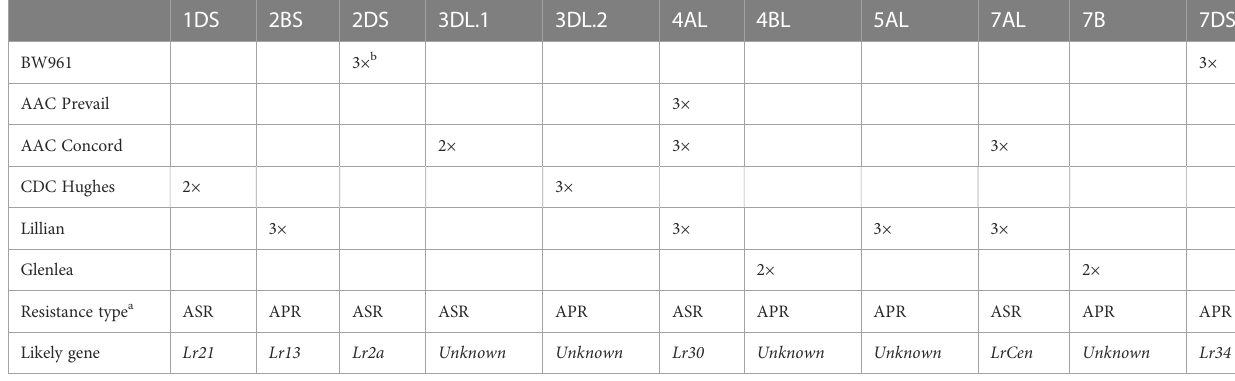
TABLE 4 Summary of QTL that were identi fi ed in the AAC Prevail/BW961, CDC Hughes/AAC Concord, and Lillian/Glenlea populations and their likely correspondence with cataloged Lr